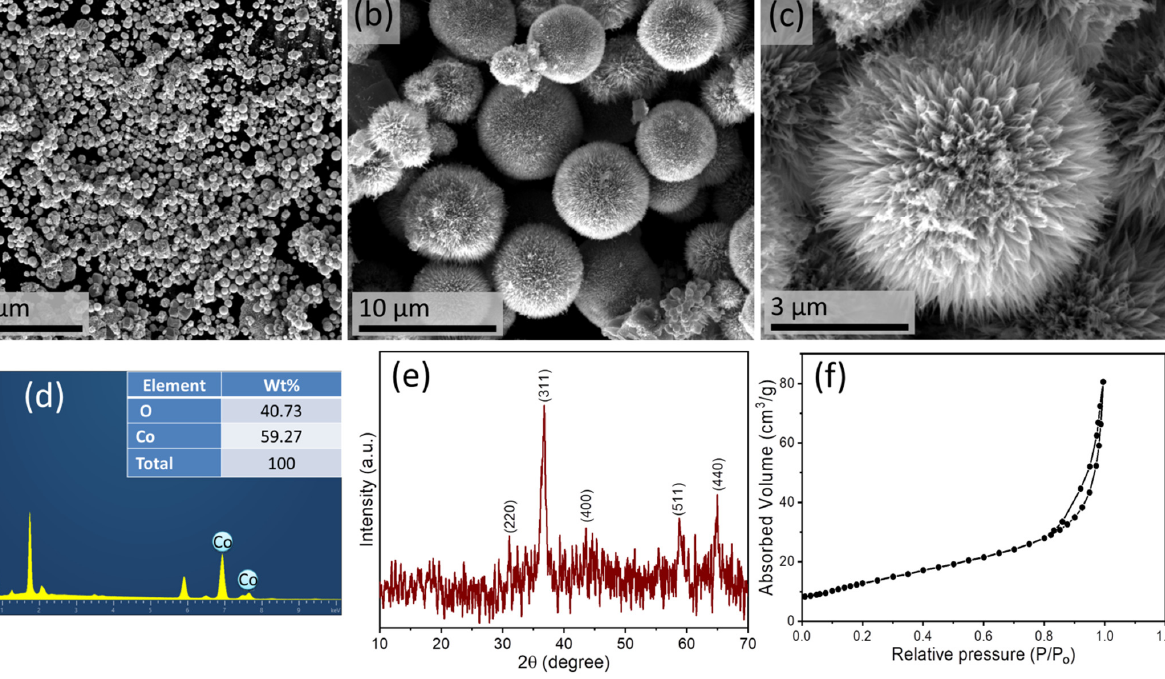
Figure 2. FESEM images at different magnifications ( a – c ), EDX analysis ( d ), XRD pattern ( e ), and BET analysis ( f ) of puffy balls-like cobalt oxide nanostructure.